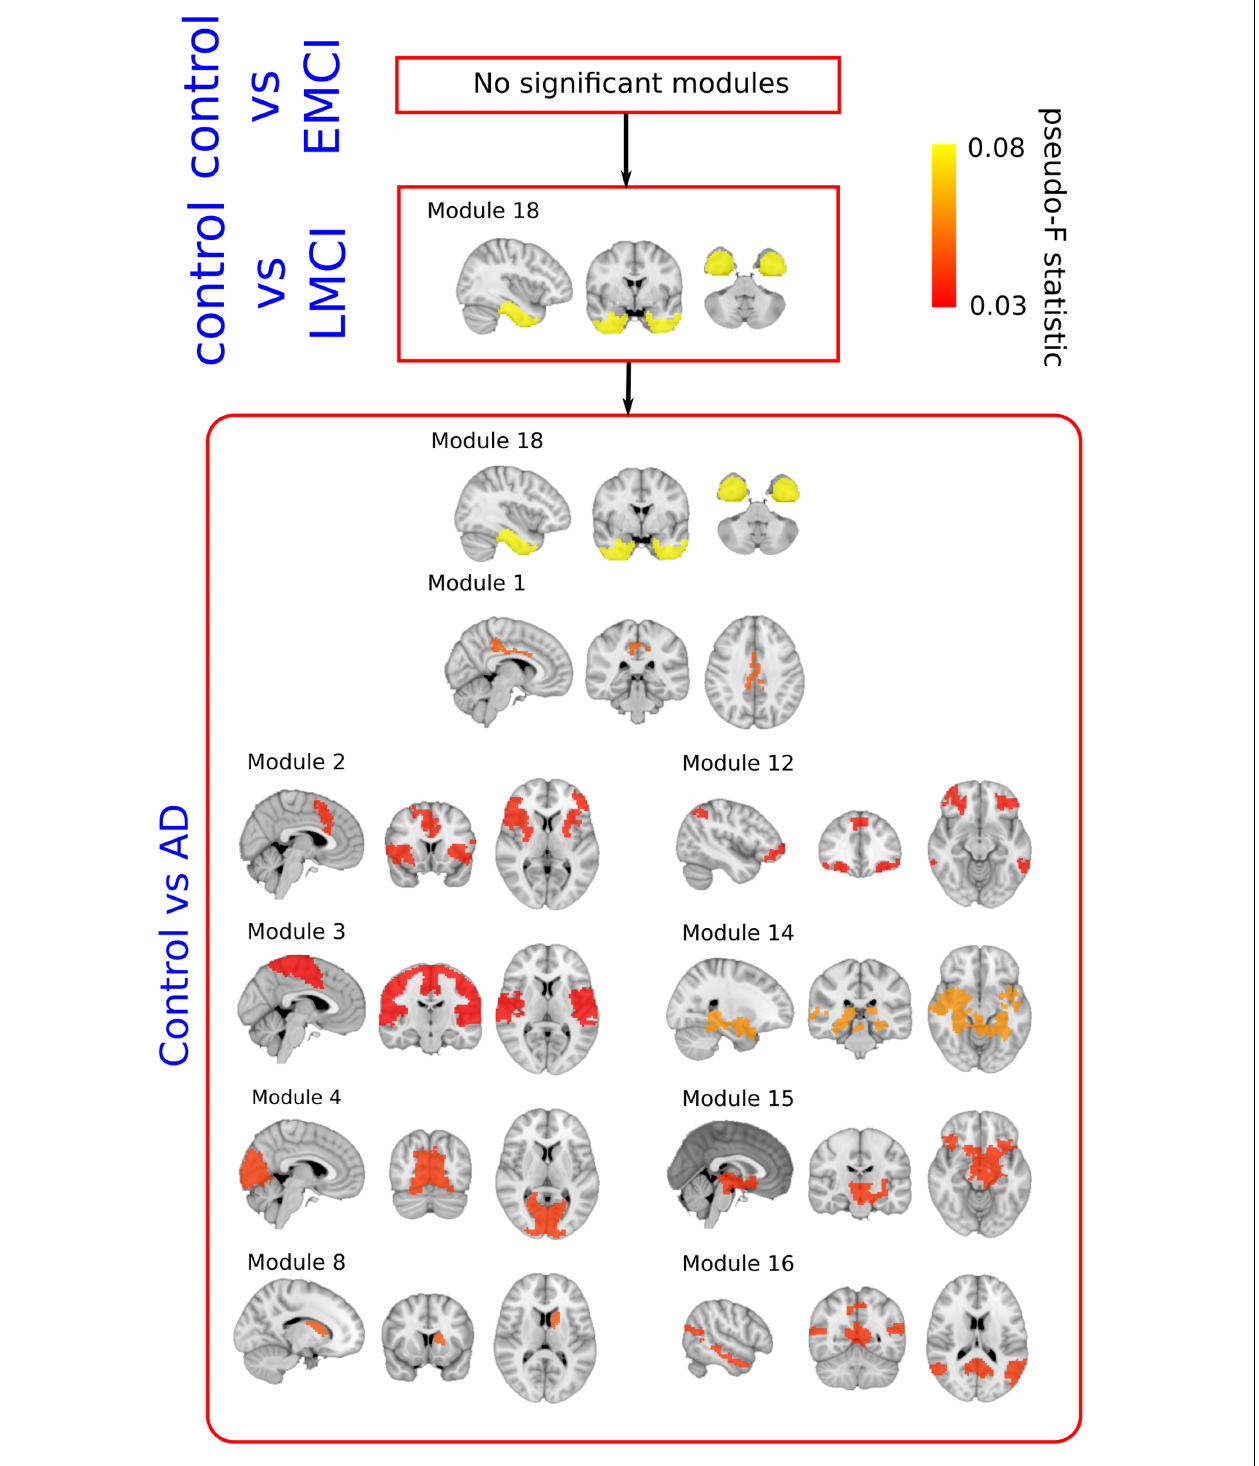
FIGURE 3 | Pseudo F-statistic brain maps across the severity progression of AD. Brain disconnection as disease progresses is quantitatively addressed by looking at the Pseudo F-statistic values of the modules. At first stages (Control vs. EMC, top), fibers deterioration is not sufficient to yield significant changes in modules connectivity patterns. In the following stage (Control vs. LMCI – middle), the connectivity pattern of module 18, which involves parts of the hippocampus, entorhinal cortex, amygdala and other memory-related areas, disconnects statistically with respect to control ( p -value = 0.007). Such connectivity differences are widely spread to the rest of the brain at the final stage (Control vs. AD,